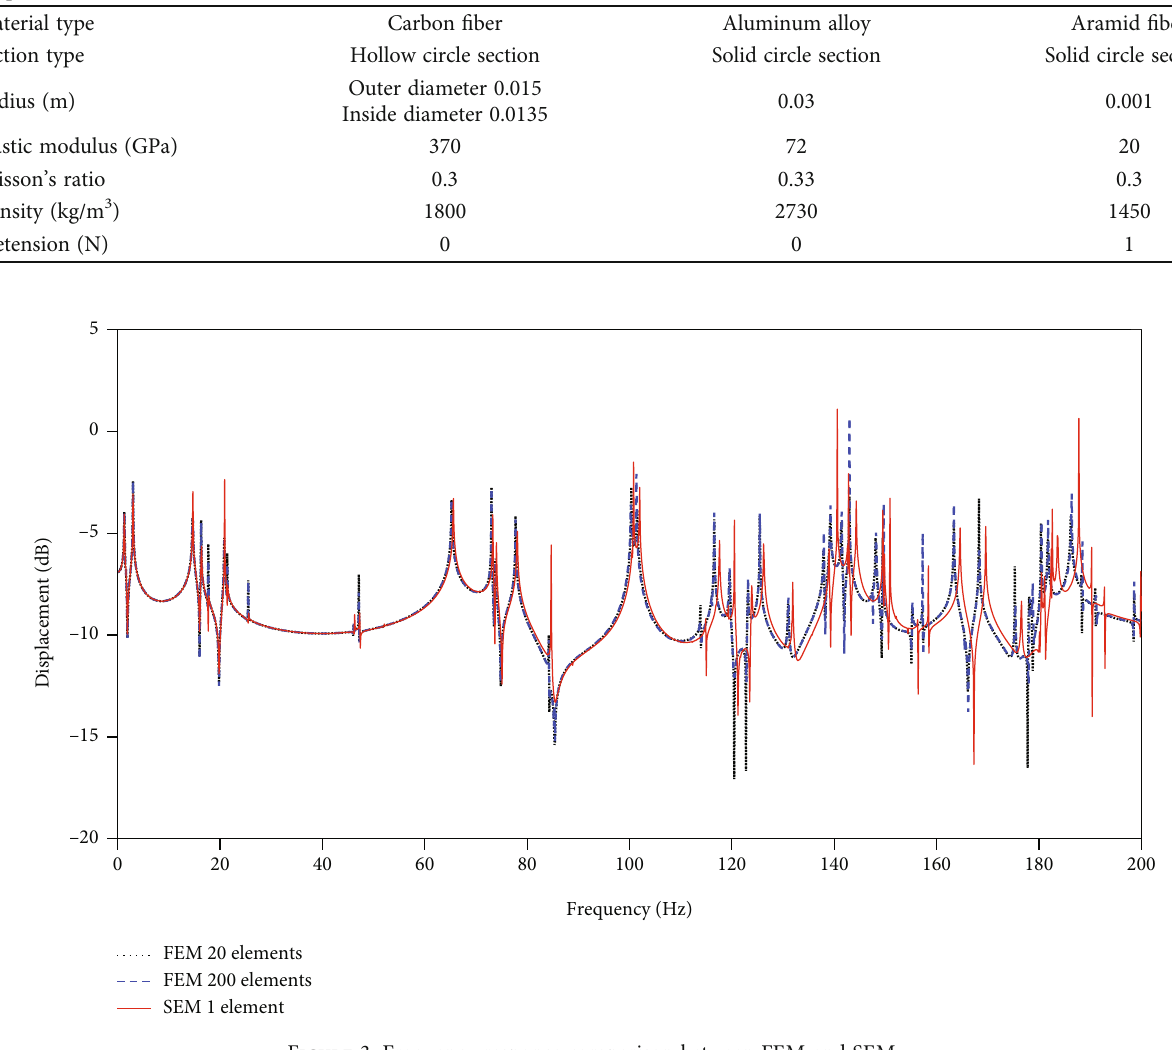
Figure 3: Frequency response comparison between FEM and